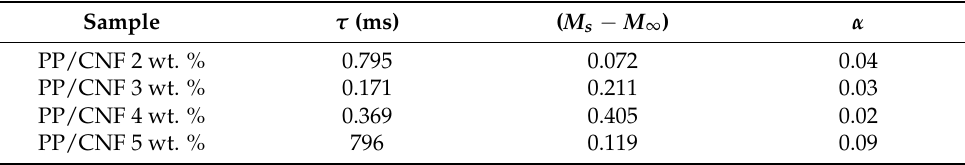
Figure 7. Nyquist plots of complex electric modulus M ∗ ( ω ) for PP/CNF composites (the dash-dot curves represent the Cole-Cole model with Equation (10)). Table 3. Parameters τ , ( M s − M ∞ ) and α of PP/CNF composites extracted by the Cole–Cole model using Equation (10).